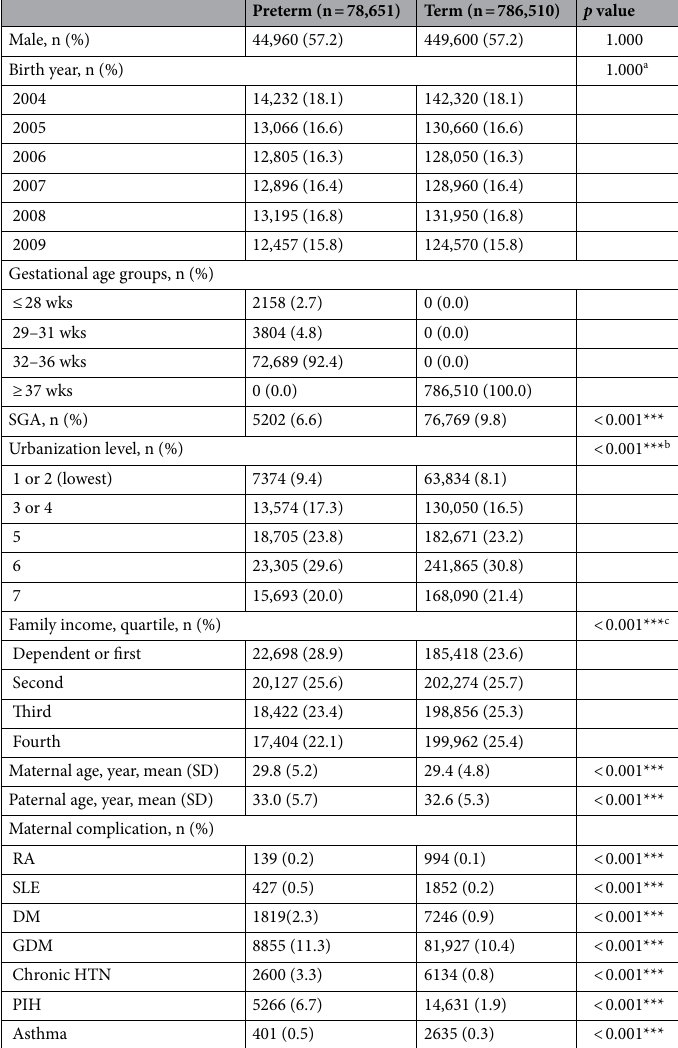
Table 1. Demographic data for the preterm and matched term infants. The family income was assessed at birth and was classified into four quartiles based on each birth year. PIH was defined as hypertension that complicated pregnancy after 20 weeks of gestation. DM diabetes mellitus, GDM gestational diabetes mellitus, HTN hypertension, PIH pregnancy-induced hypertension, RA rheumatoid arthritis, SGA small for gestational age, SLE systemic lupus erythematosus. a The p value implied the differences of the birth year distributions between preterm and term infants. b The p value implied the differences of urbanization distributions between preterm and term infants. c The p value implied the differences of family income distributions between preterm and term infants. *** p <